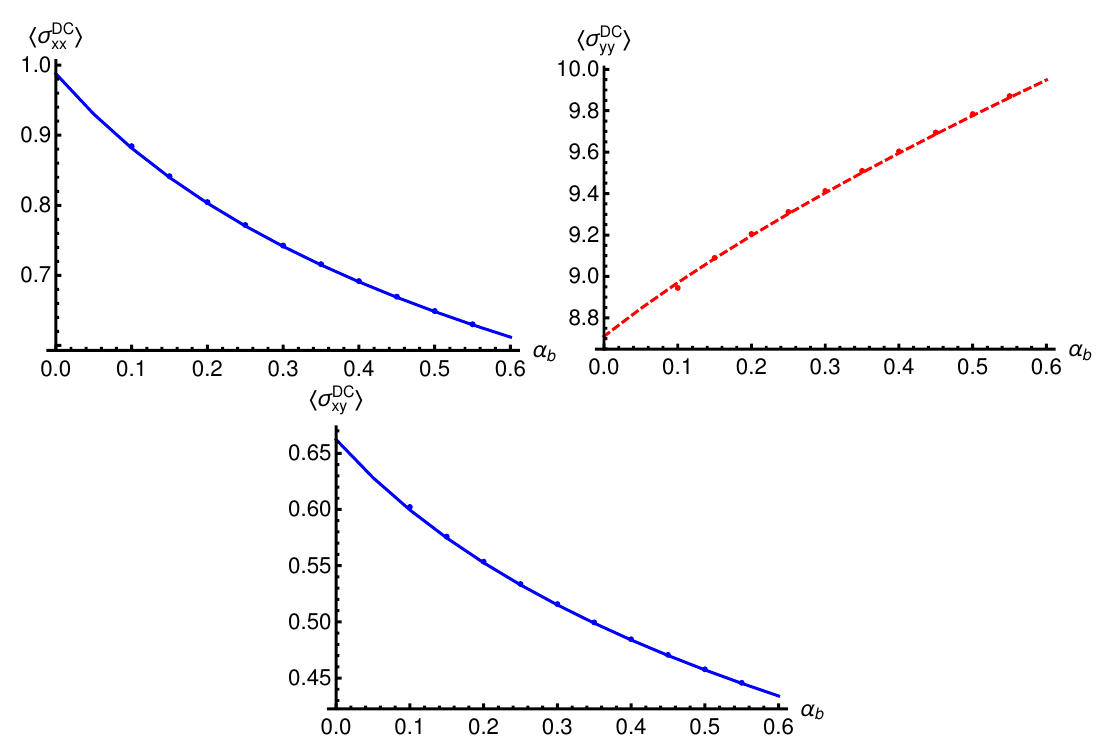
Figure 8 . The averaged pinned DC conductivities for magnetic lattice at b = 0 . 5 . The curves show the analytic results from eqs. (4.2)–(4.4), and the dots are the optical conductivities extrapolated to ω = 0